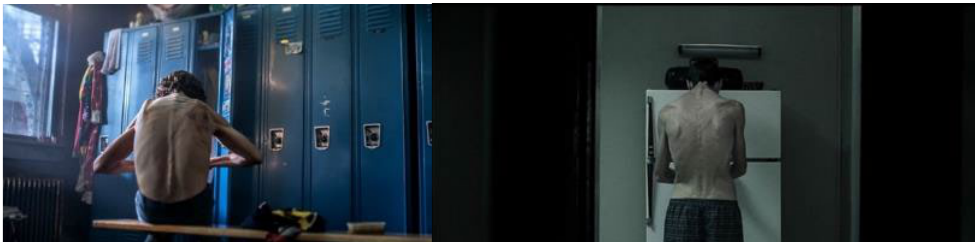
Figures 16-17 Arthur Fleck’s skeletal body in Joker ; Trevor Reznik’s (Christian Bale) emaciated frame in The Machinist (Brad Anderson, 2004) which also deals with a man struggling with psychological disruption in this case, insomnia and repressed guilt for a hit and run incident resulting in the death of a child Phoenix describes how he saw the foundation of the character as very damaged and fragile.